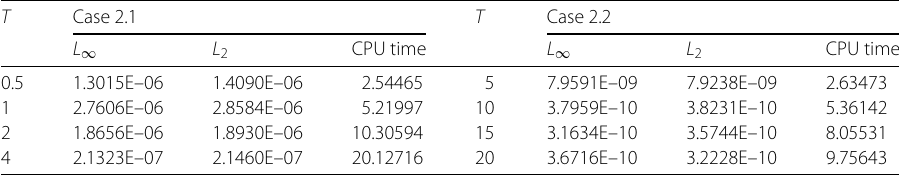
Table 9 Error norms of Example 2 using regular